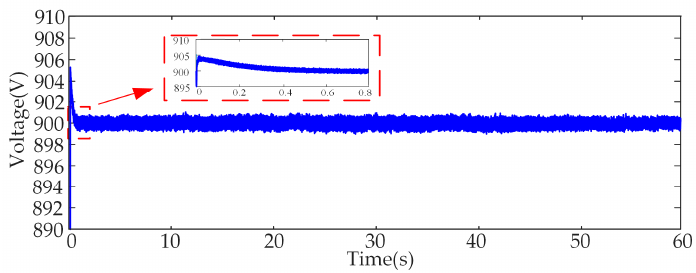
Figure 13. DC bus voltage under regular incident waves. Figure 12. Grid ‐ connected active and reactive power.